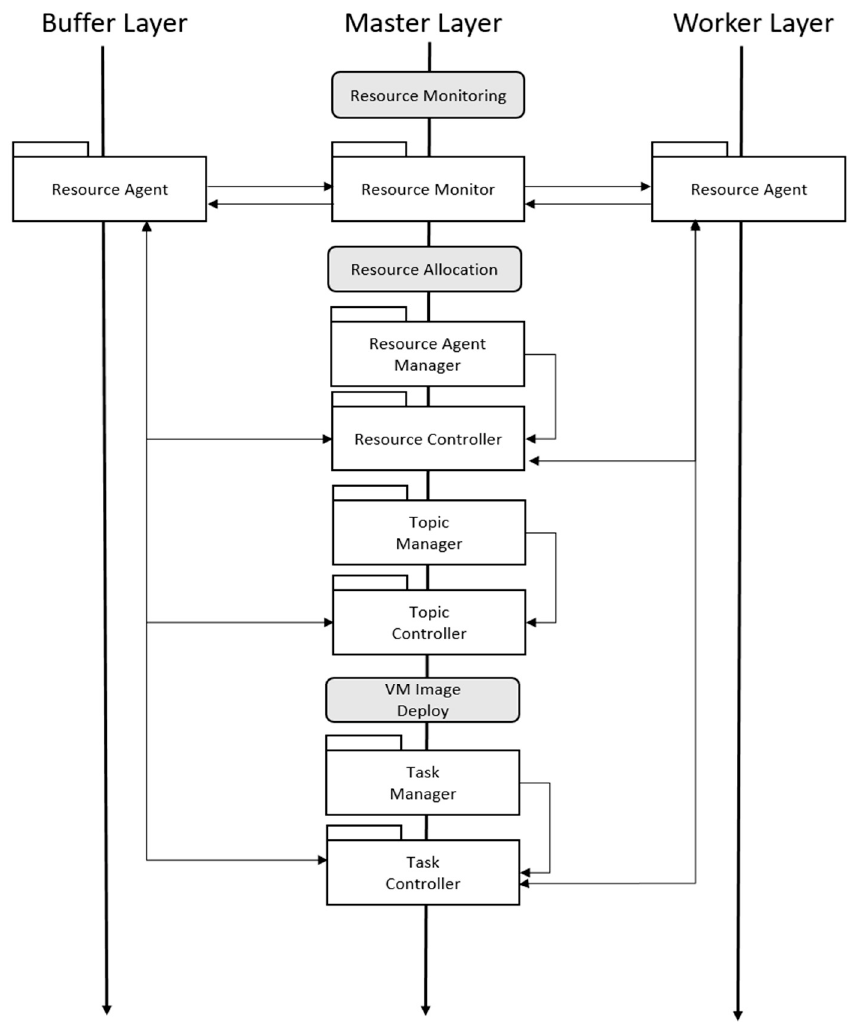
Figure 6. Module operation process on Master Layer .